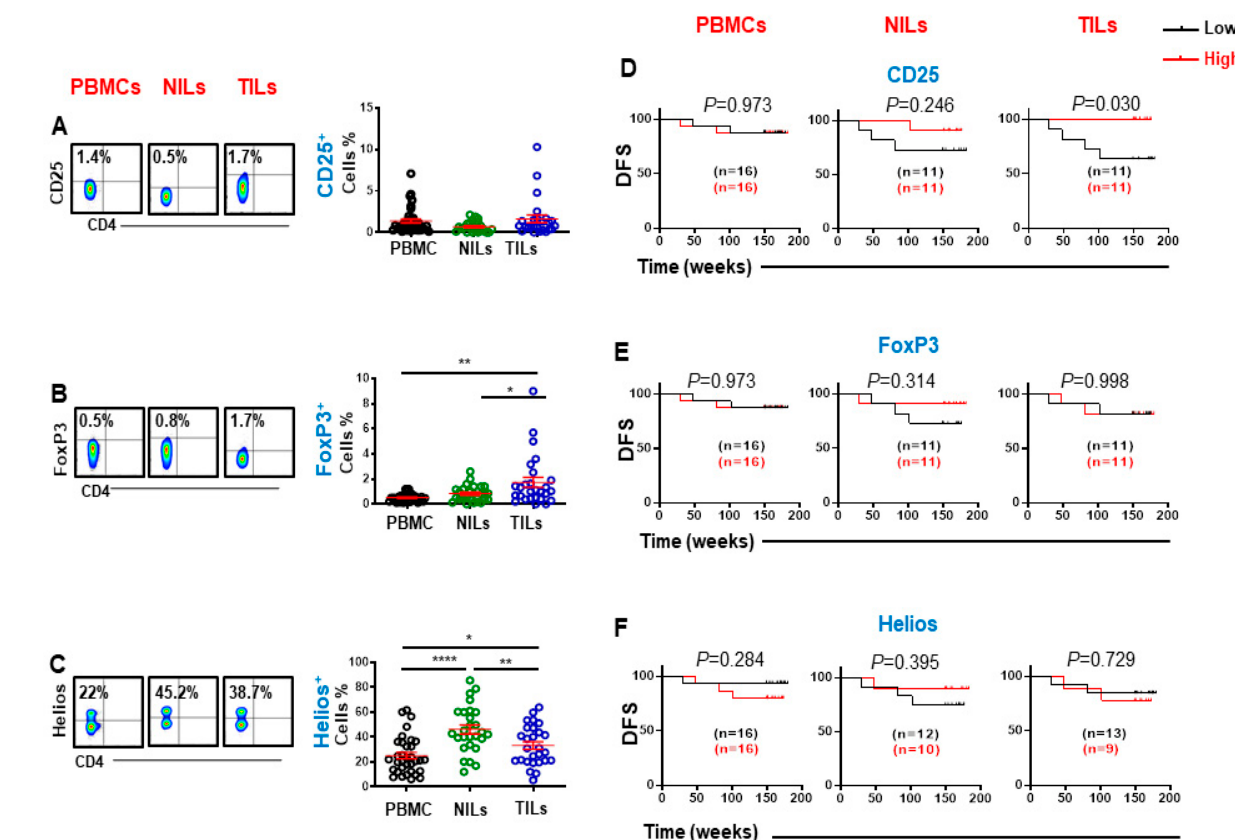
Figure 1. Flow cytometric plots, scatter plots and Kaplan–Meier survival curves for DFS based on the levels of CD25-, FoxP3-, and Helios-expressing CD3 + CD4 − T cells. Representative flow cytometric plots and scatter plots present CD25 ( A ), FoxP3 ( B ) and Helios ( C ) expression in CD8 + T cells in PBMCs, NILs and TILs. CRC patients with high levels of CD25 ( D ), FoxP3 ( E ) and Helios ( F ) expressing CD8 + T cells were compared with patients with low levels of these cells to determine DFS. The number of patients included in each comparison are specified on each survival curve. Statistical analysis are shown with significance levels indicated at * p < 0.05, ** p < 0.01, and **** p < 0.0001.